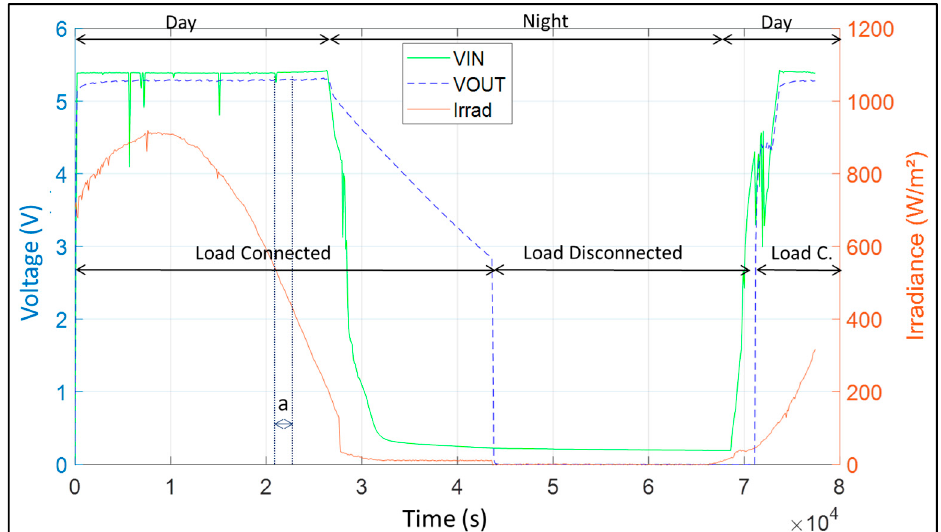
Figure 14. Implementation of the proposed variable storage architecture (with C small = 100 mF and C big = 400 mF) into a wireless sensor node powered by a photovoltaic cell (PV): evolution of irradiance, input and output voltages of adaptive UC over one day.